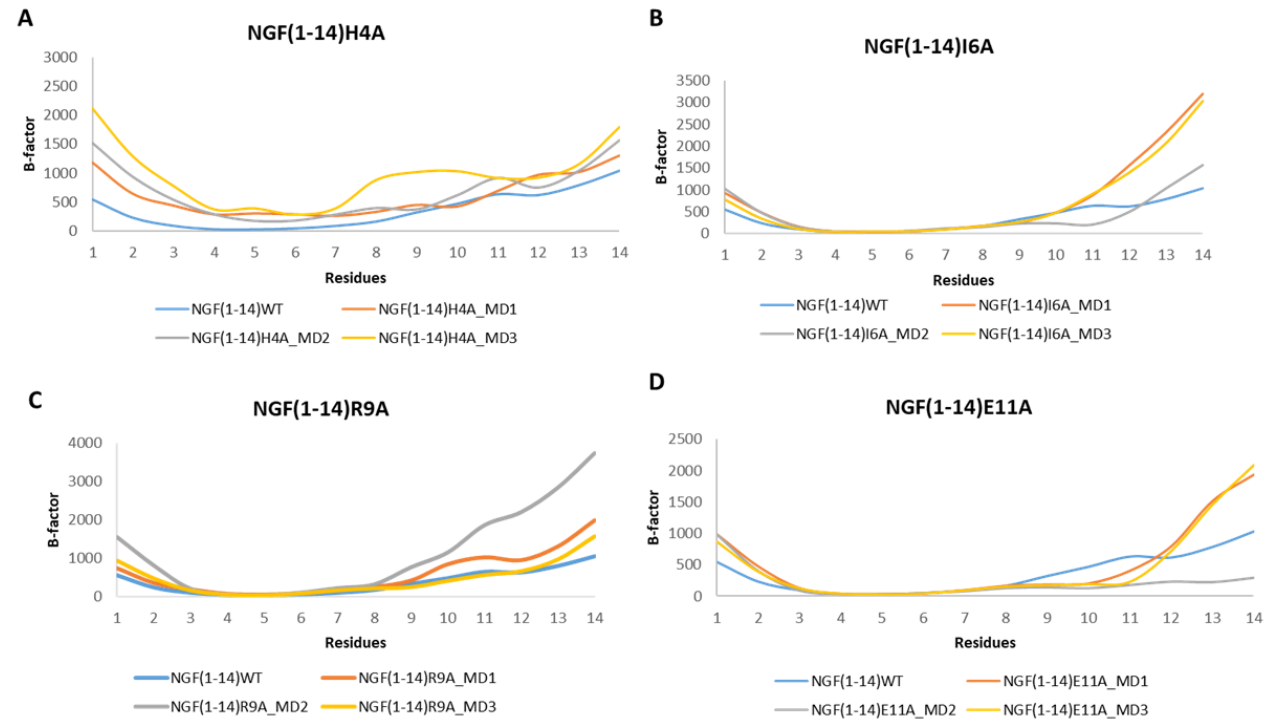
Figure 11. RMSF profiles of the NGF(1–14) mutants H4A ( A ), I6A ( B ), R9A ( C ) and E11A ( D ) obtained for each MD run.